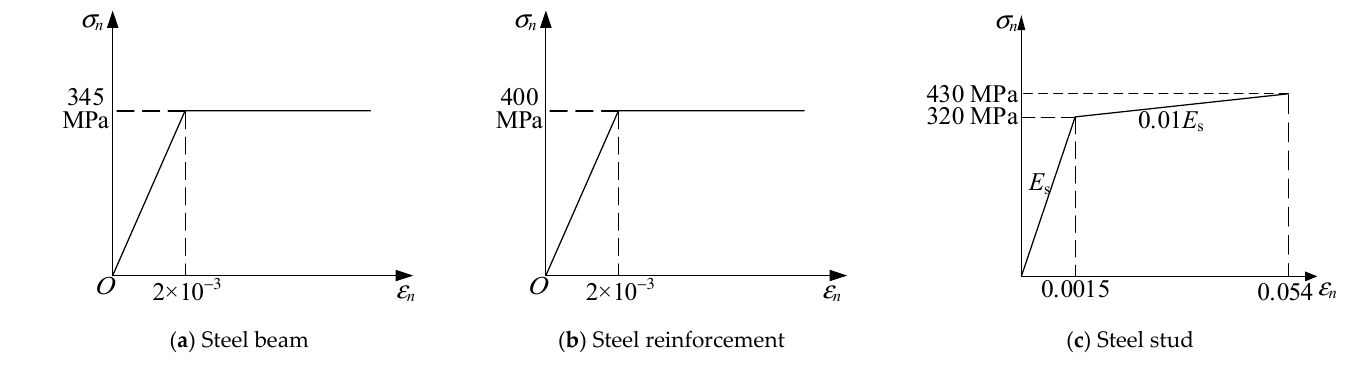
Figure 7. Stress ‒ strain curve of the steel.